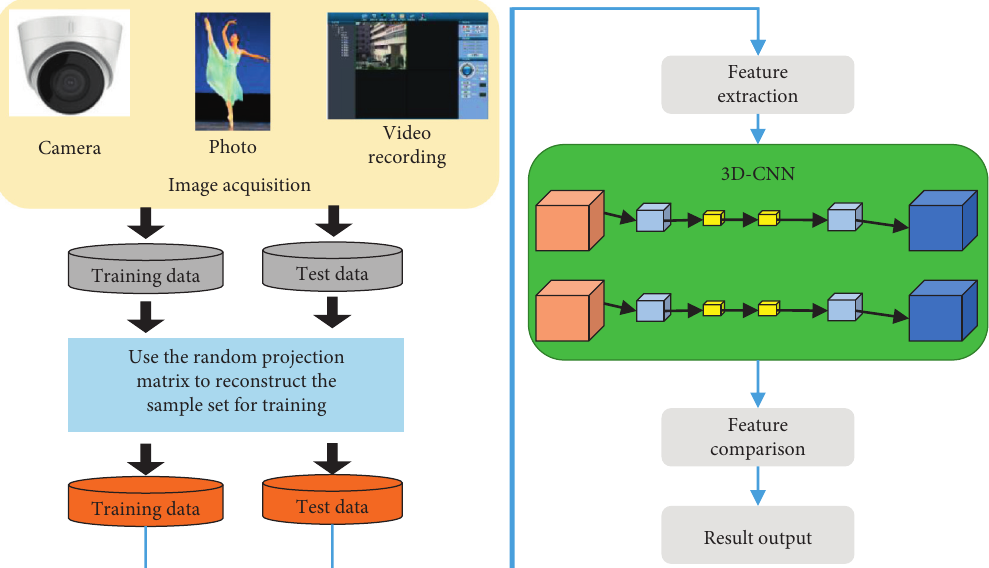
Figure 1: Flow chart of human motion